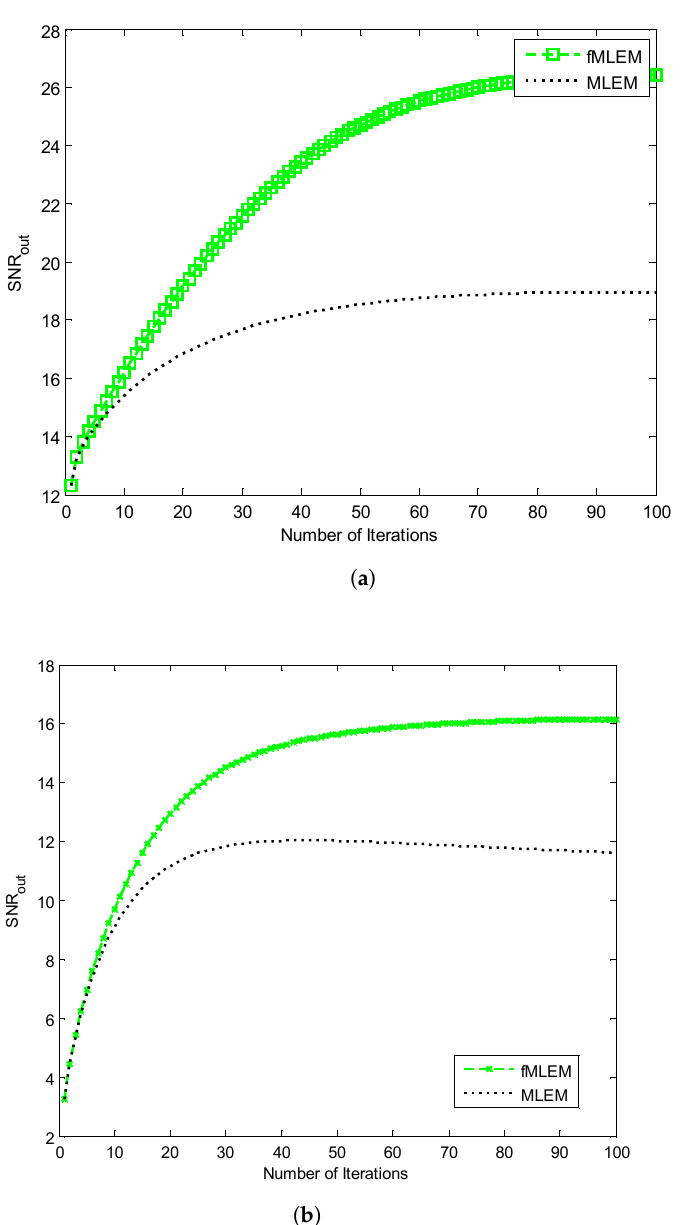
Figure 10. SNR vs. the number of iterations for ( a ) Huffman Brain and ( b ) Abdomen Phantom